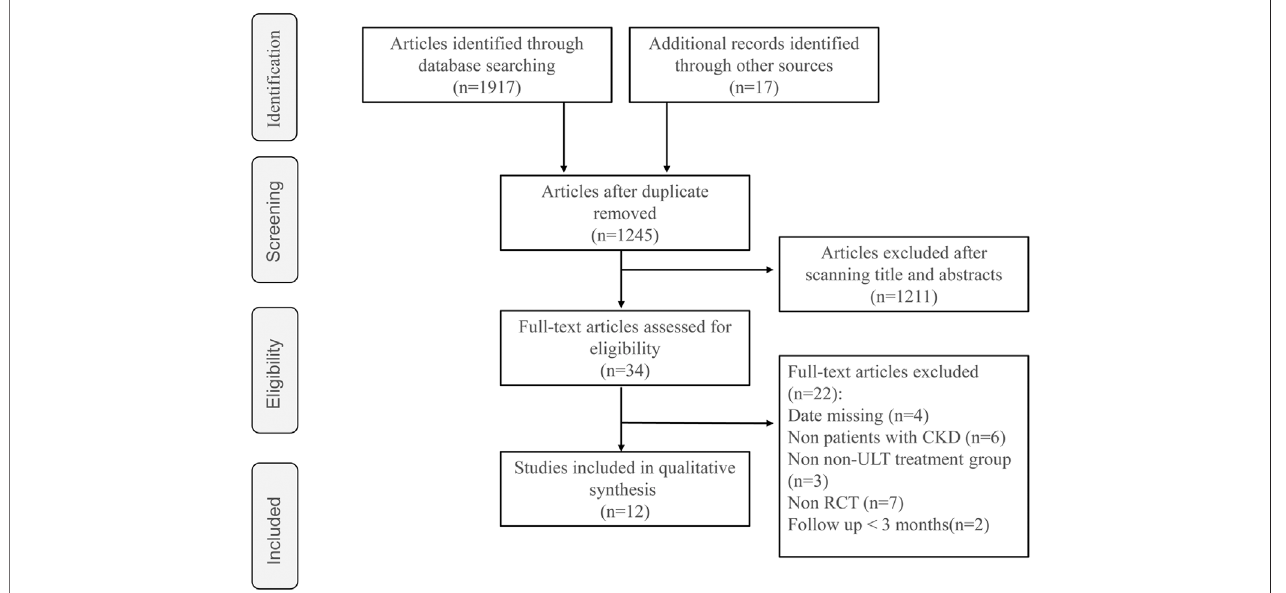
FIGURE 1 | Flowchart of the study selection procedure.